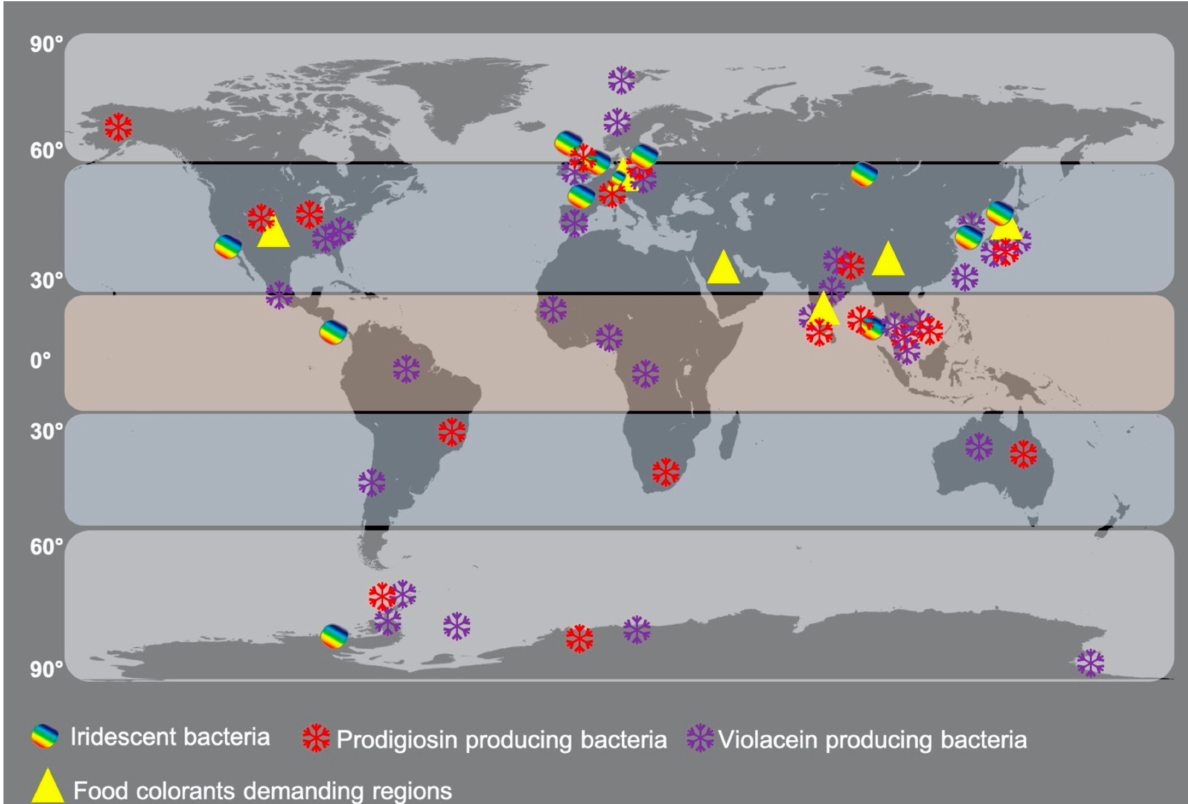
Figure 4. Cosmopolitan distribution of well-known pigmented microbes in different geographical